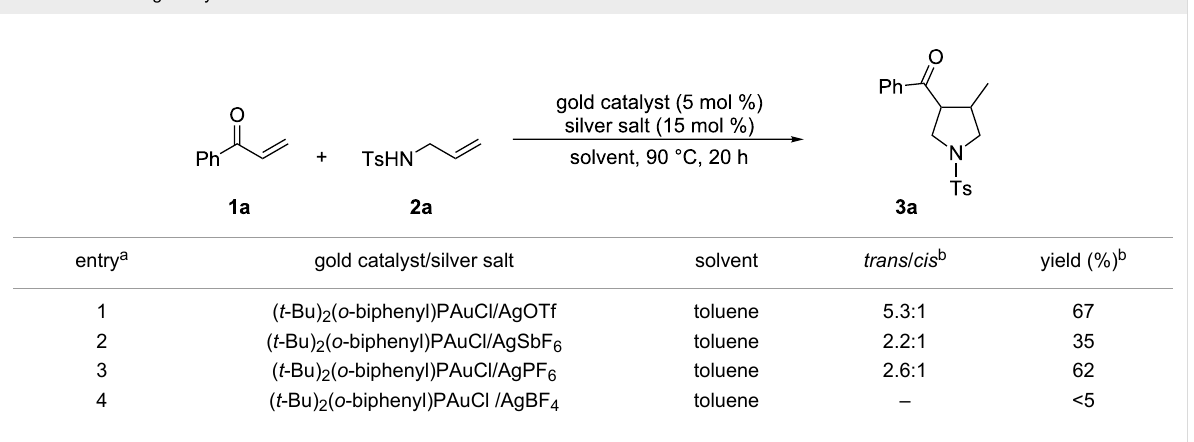
Table 2: Screening catalysts and